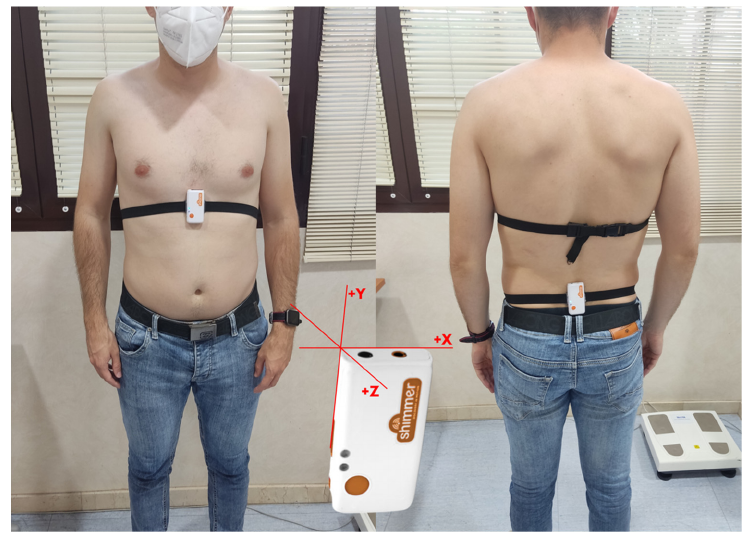
Figure 1. Shimmer 3 IMU: Placement and coordinate references (X, Y, Z axes).